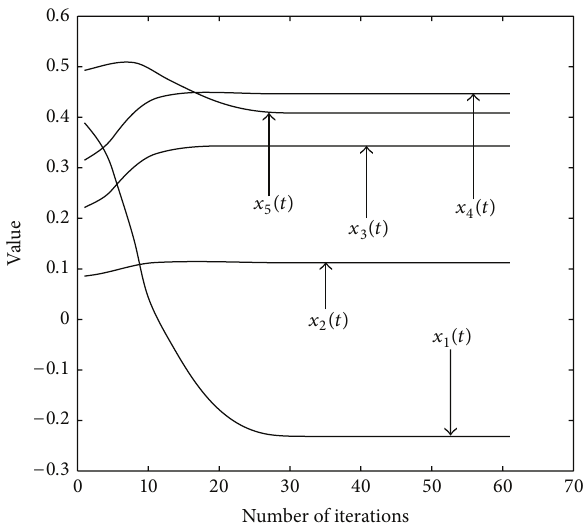
Figure13:Trajectoriesof 𝑥(𝑡) ,thesolutionof (10)withinitial 𝑥(0) as (65), which should converge to the imaginary part of an eigenvector of 𝐴 𝑝 corresponding to the eigenvalue 𝜆 2 .